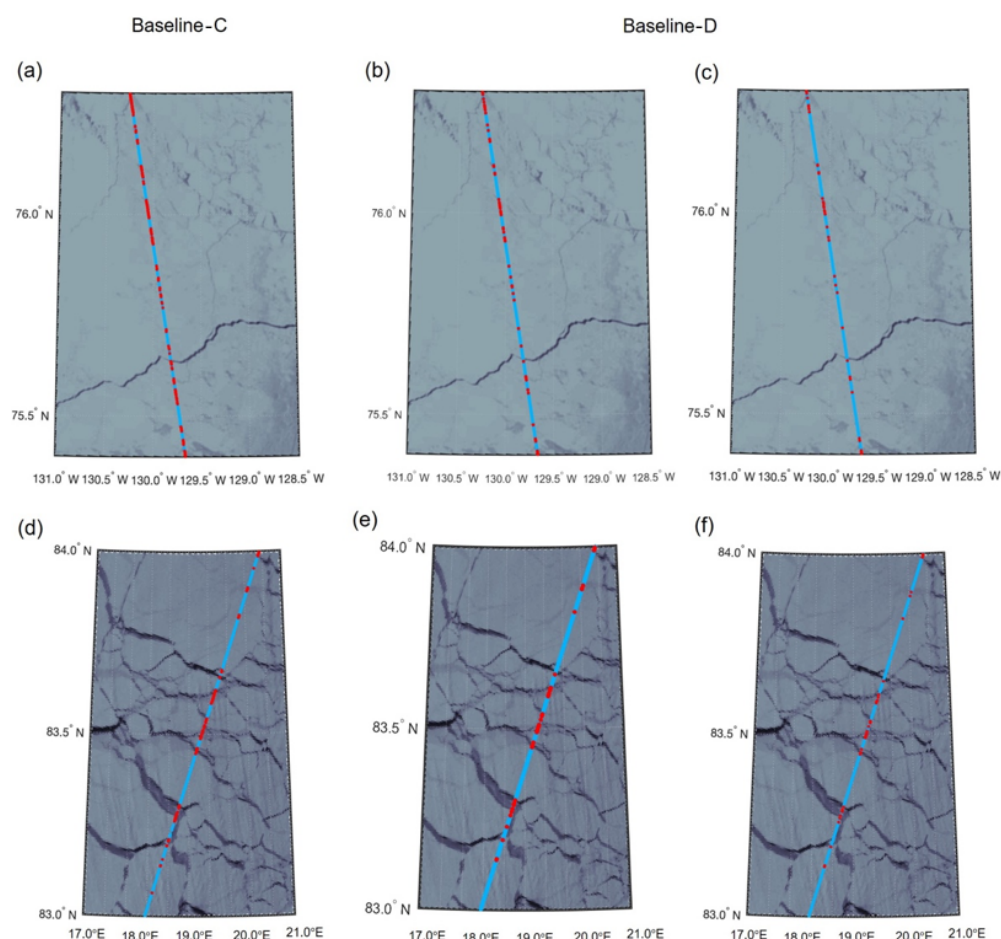
Figure 12. While red dots represent lead, light blue dots represent ice. (a–c) The MODIS images are from 17 October 2013, 22:10UTC; CryoSat-2 passes over after 21min. (d–f) The MODIS images are from 17 April 2014, 22:10UTC; CryoSat-2 passes over after 5min. The lead classification of Baseline-C based on Tilling et al. (2018) (a, d) . The lead classification of Baseline-D based on Tilling et al. (2018) together with stack peakiness (b, c, e, f) . (b, e) Leads are identified over stack peakiness over 13. (c, f) Leads are identified over stack peakiness over